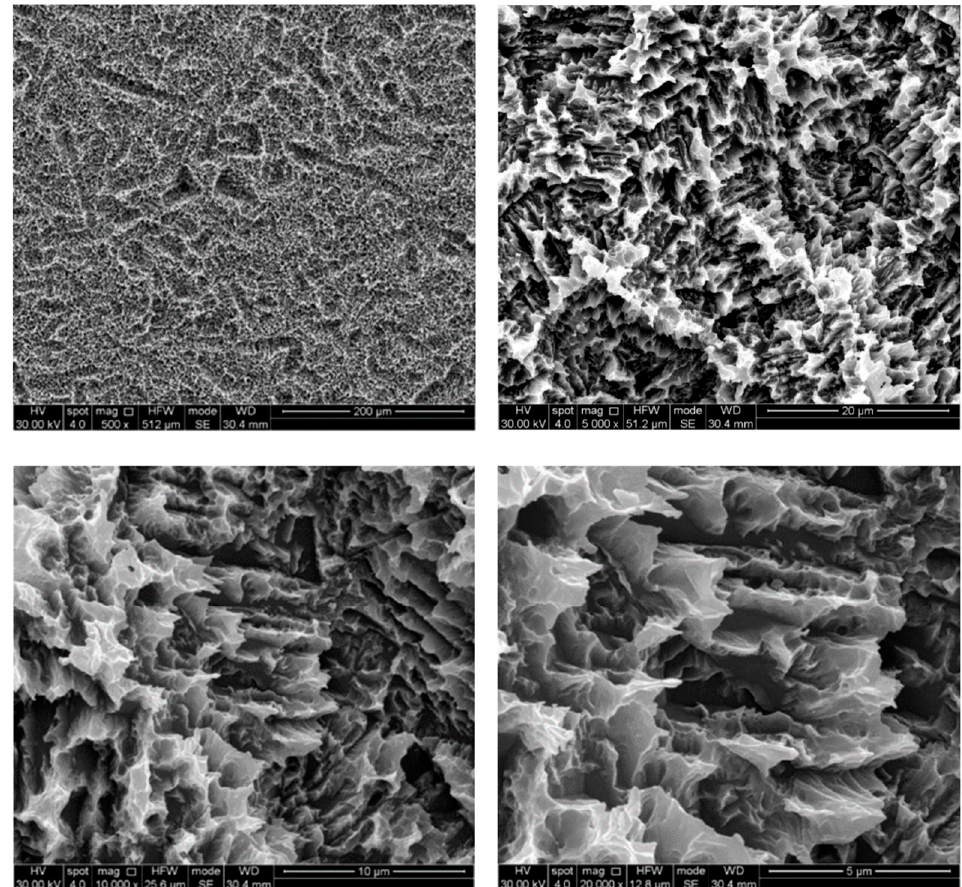
Figure 2. SEM images of control disk (CTR) samples. Magnifications from 500 × to 20,000 ×.